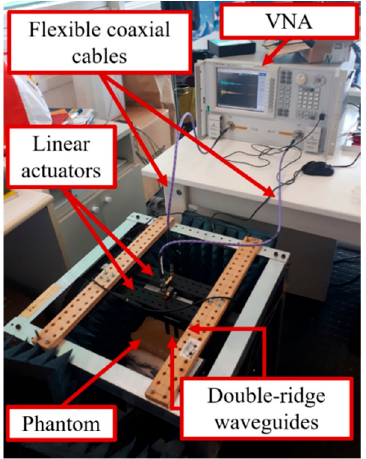
Figure 1. Experimental setup used for signal acquisition.